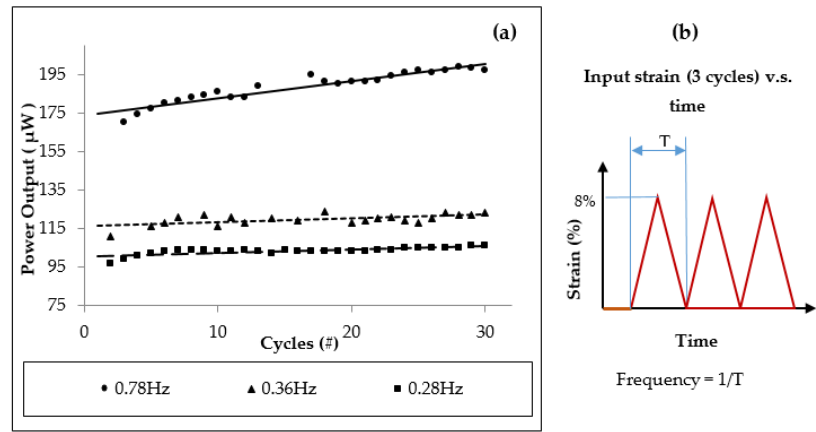
Figure 7. Power output versus elongation frequency (Hz). ( a ) The nanogenerator elongation was performed with three different frequencies; 0.78 Hz, 0.36 Hz and 0.28 Hz. As expected, the higher frequency will deliver the higher power. The elongation cycles (repetitions) were performed from 3 cycles to 30 cycles with different frequencies. In the case of higher frequency and higher number of cycles, the power increased. ( b ) Explanation of the elongation frequency. The frequency is considered equal to the number of device stretch/release per second.